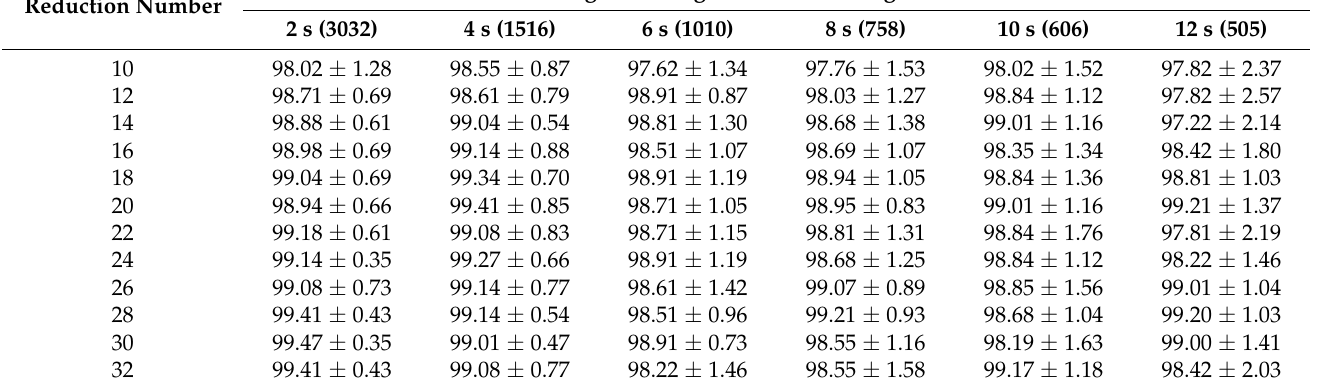
Table 7. The effect of segment length and reduction number on KNN classification accuracy based on CSP+LogEn FE method.